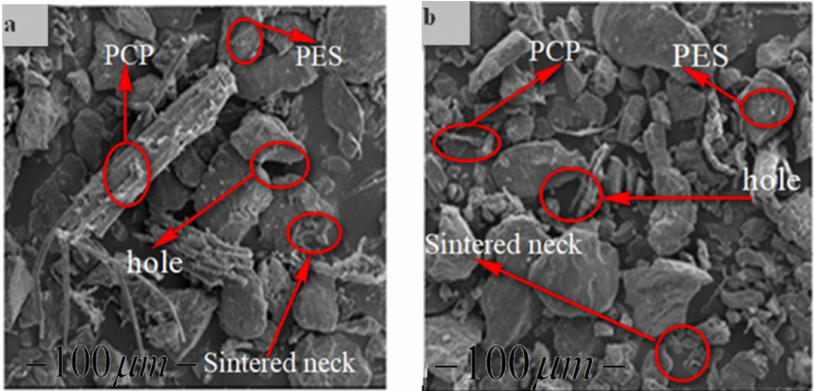
Figure 8. Surface morphology of ( a ) PCPC parts (20% PCP) and ( b ) PCPC parts (10%